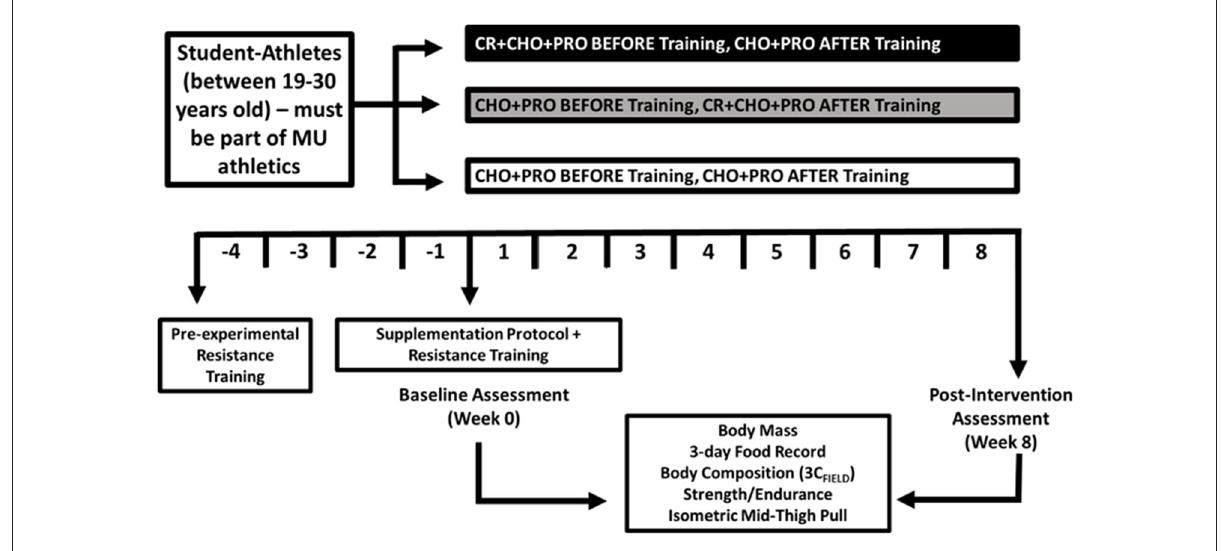
FIGURE1 Research design